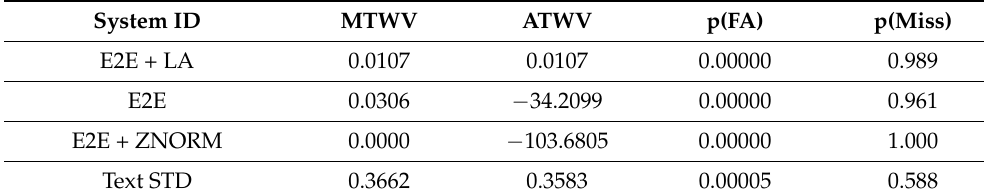
Table 17. System results of the QbE STD task for SPARL20 test